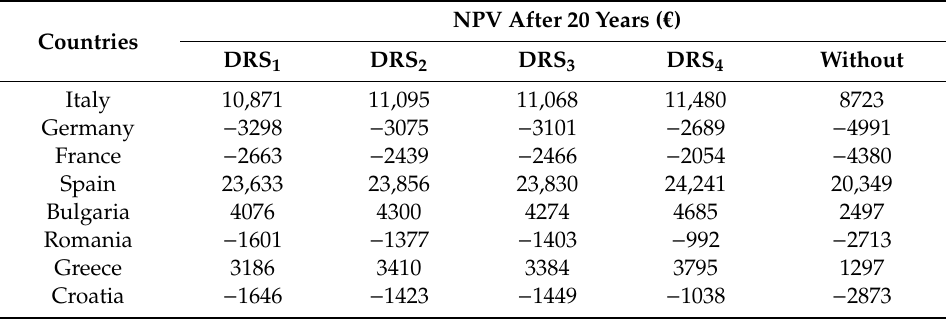
Table 16. NPV values after 20 years (increment power 10%).